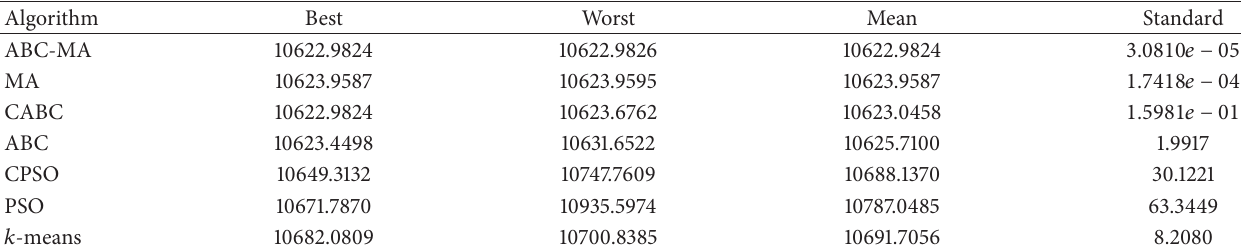
Table 8: Results obtained by the algorithms for 20 different runs on Statlog (Heart) data.